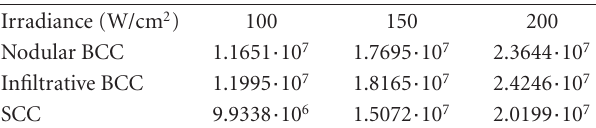
Table 3: Maximum amount of singlet oxygen molecules in the tu- mor